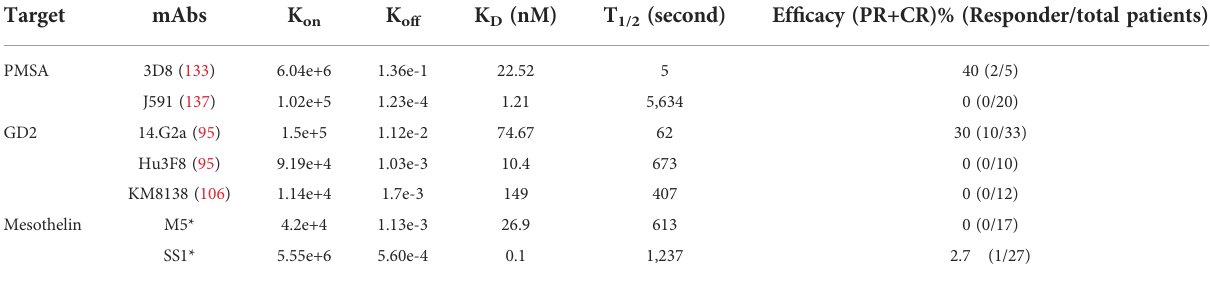
TABLE 2 Relationship of K off and T1/2 of ABDs and clinical ef fi cacy of CARTs.